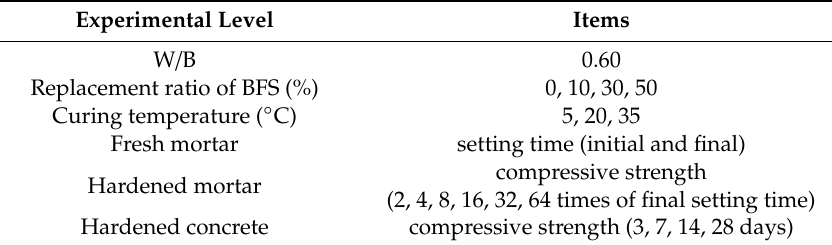
Table 1. The experimental variables.